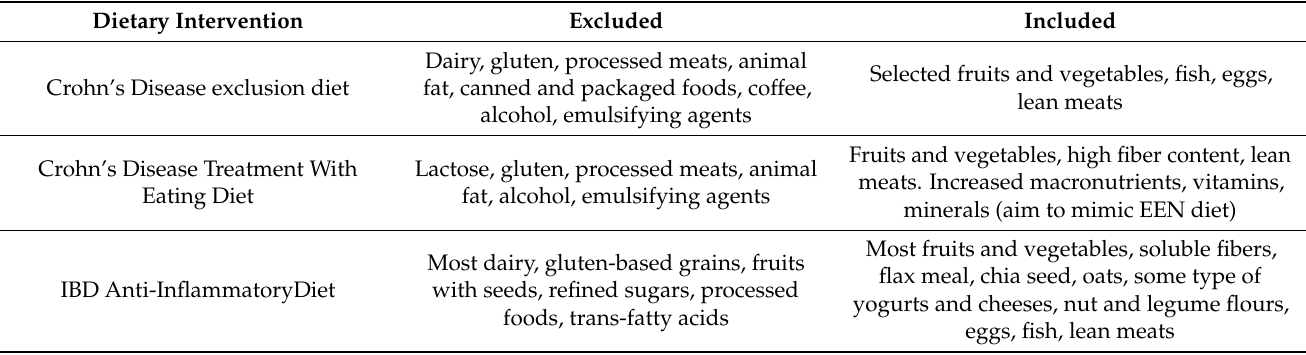
Table 4. Exclusion diets with related included and excluded food groups - adapted from [71]. Dietary Intervention Excluded Crohn’s Disease exclusion